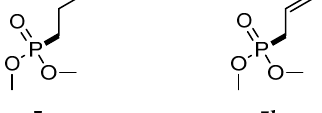
Figure 3. Chemical structures aliphatic phosphonates 5a and 5b .